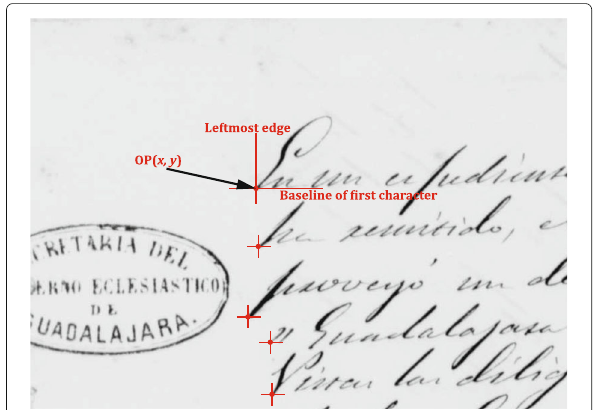
Fig. 7 Illustration of OPs